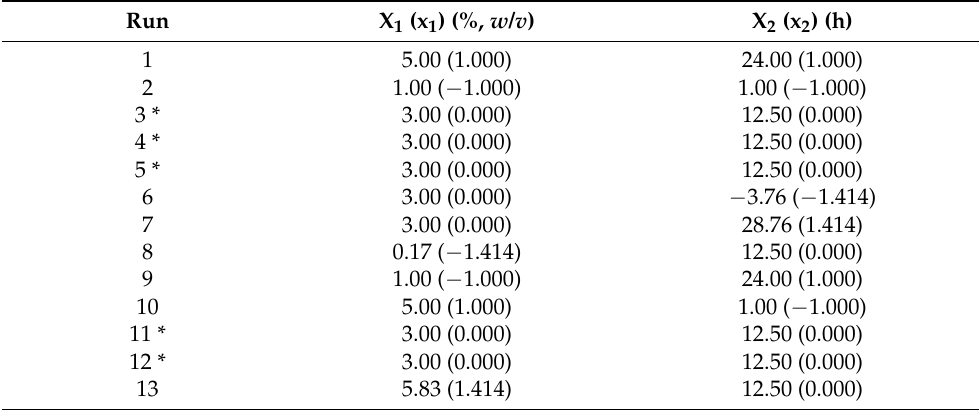
Table 1. Actual and coded (in parentheses) levels of PDMS concentration (X 1 /x 1 ) and treatment time (X 2 /x 2 ) used for the optimisation of the hydrophobic surface coating process on the borosilicate glass and stainless steel